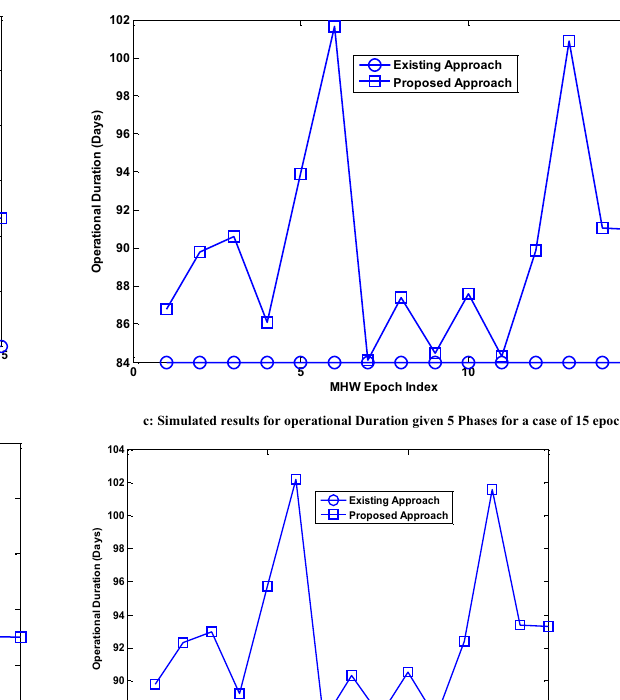
c: Simulated results for operational Duration given 5 Phases for a case of 15 epochs.